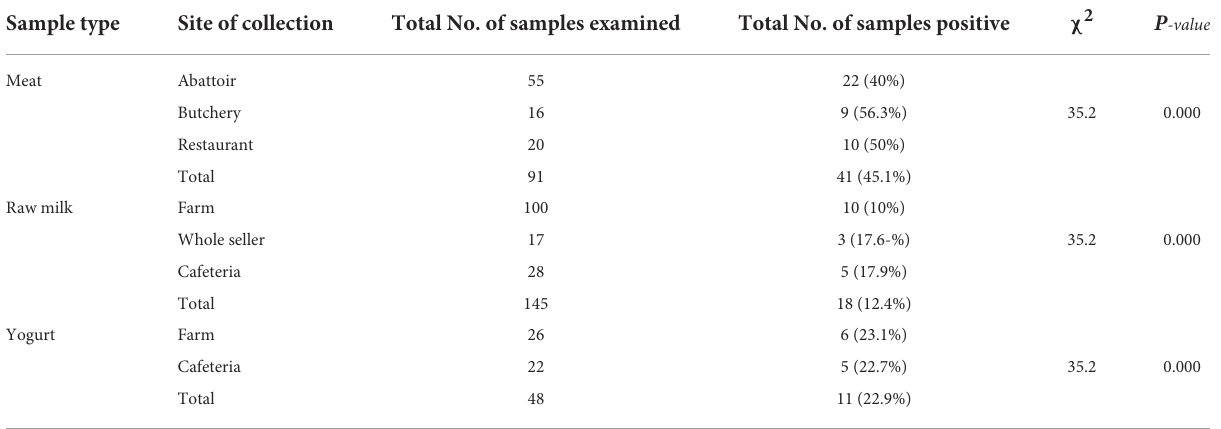
TABLE 2 Occurrence of E. coli among the different sample types and sample sources.